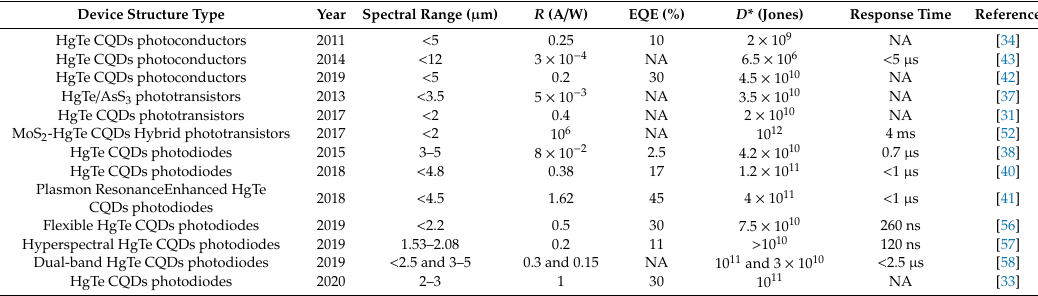
Table 1. Performance comparison between HgTe CQDs